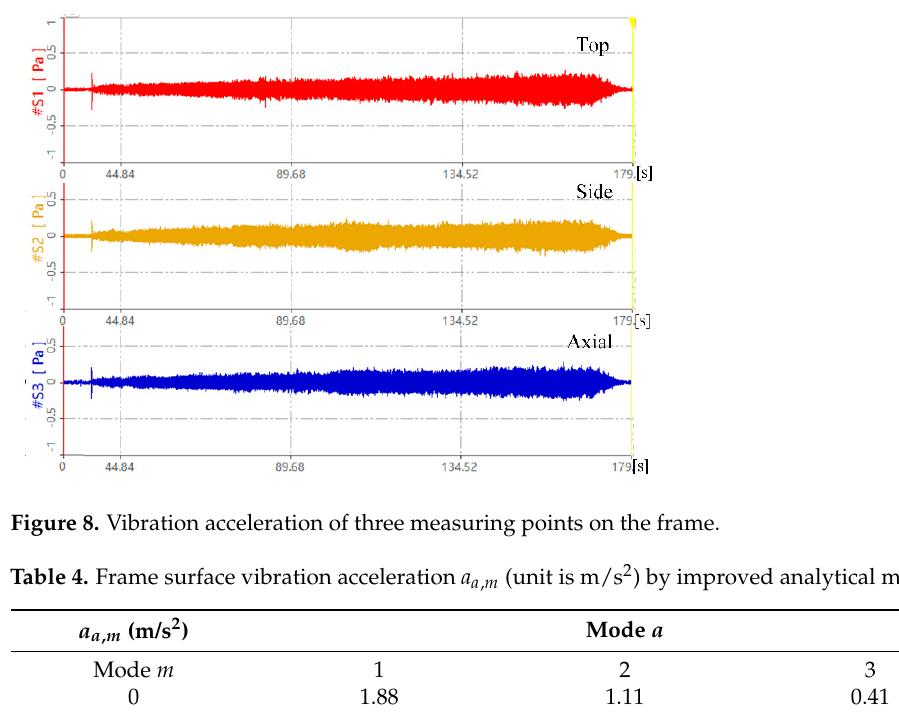
Figure 7. The vibration acceleration spectrum of the top point #A1 in 10 stages. ( a ) Stage 1, f = 0.1 f 1 ; ( b ) Stage 2, f = 0.2 f 1 ; ( c ) Stage 3, f = 0.3 f 1 ; ( d ) Stage 4, f = 0.4 f 1 ; ( e ) Stage 5, f = 0.5 f 1 ; ( f ) Stage 6, f = 0.6